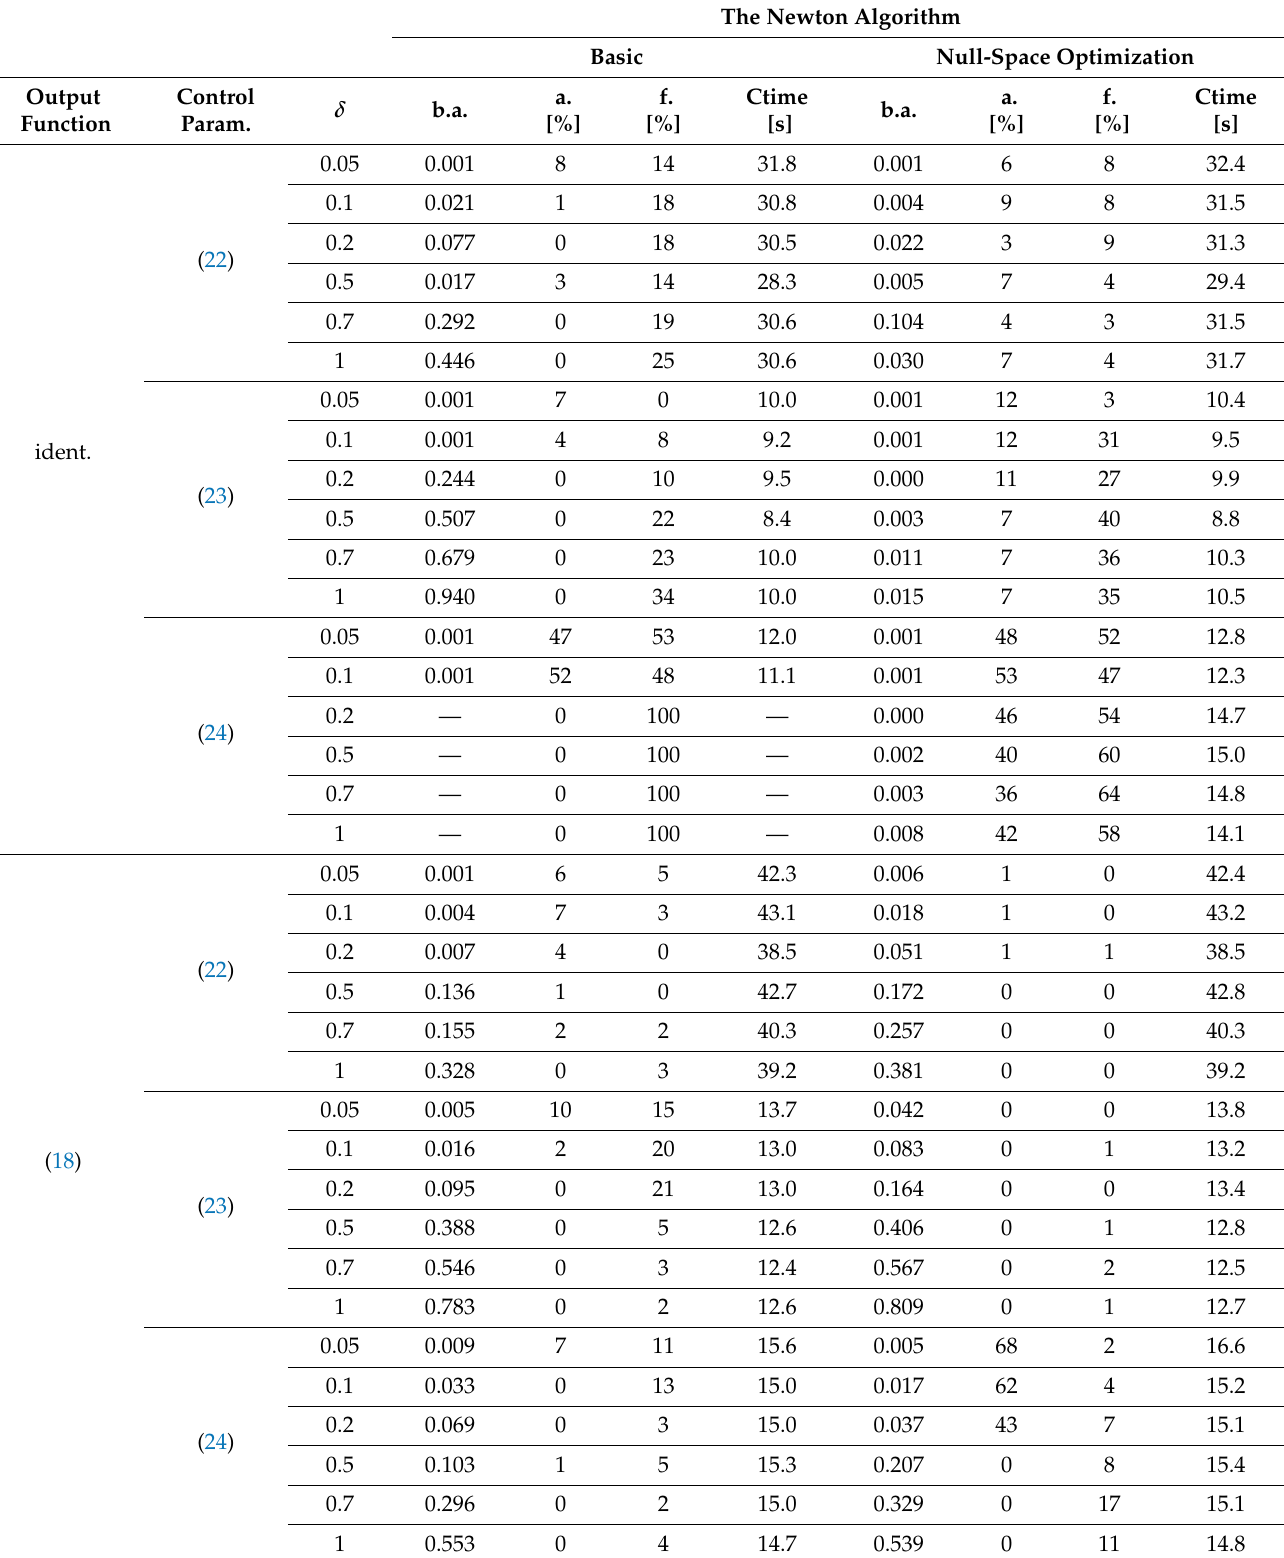
Table 3. Accuracy, numeric failures, and computing time for the kinematic car